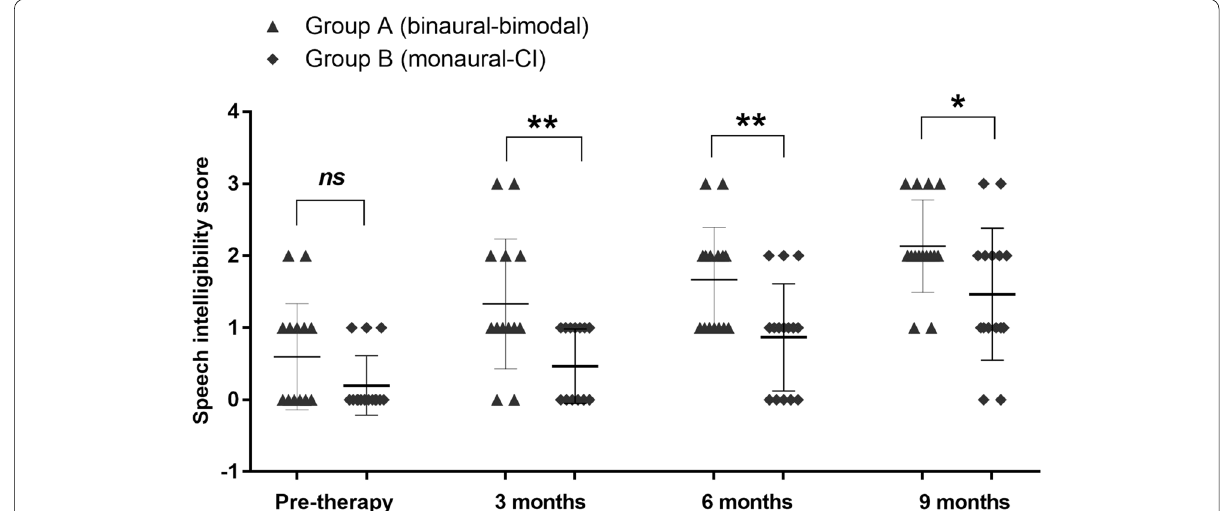
Fig. 5 Showing better speech intelligibility score in group A (bimodal) compared to group B (monaural CI). Results of Mann‑Whitney test show better performance over time in group A. CI, cochlear implantation; ns, nonsignificant, *significant ( P < 0.05), **significant ( P <